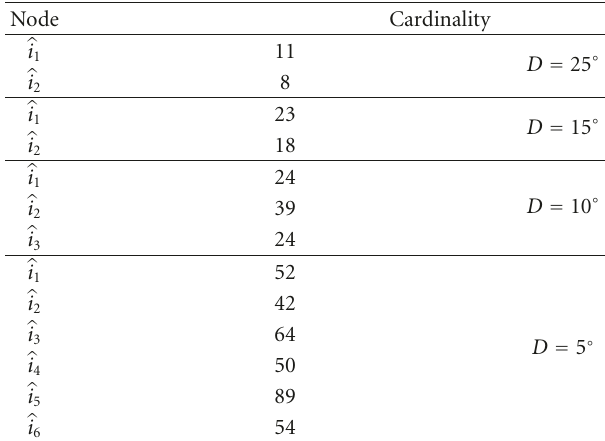
Table 1: Cardinalities of sets V (cid:4) and D = 5 ◦ ,